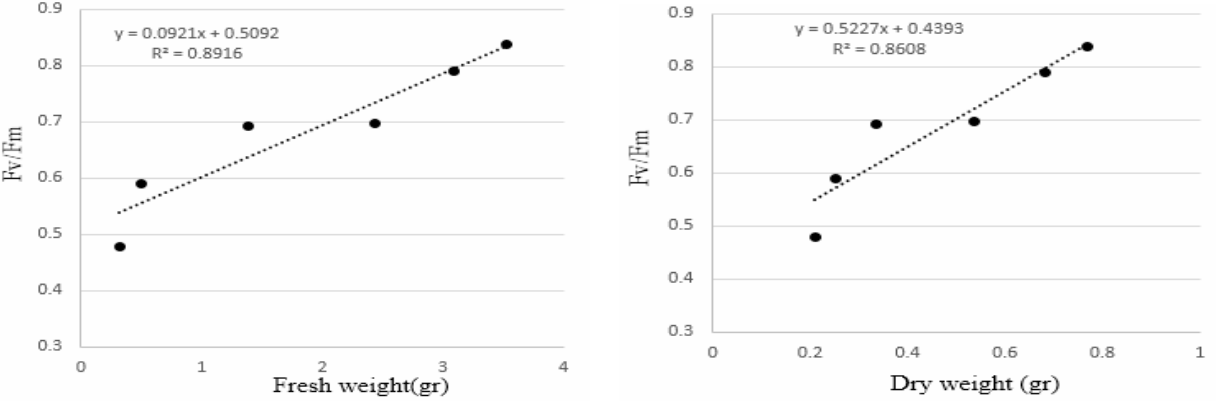
Fig. 4. Relationship between Fv/Fm parameter and days after treatment: a; sethoxydim only and b; sethoxydim plus turnip oil